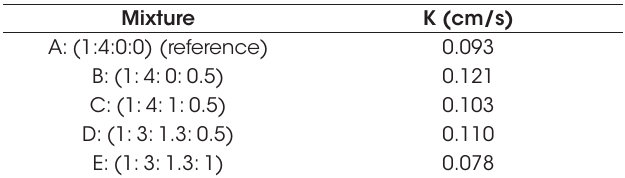
Permeability results